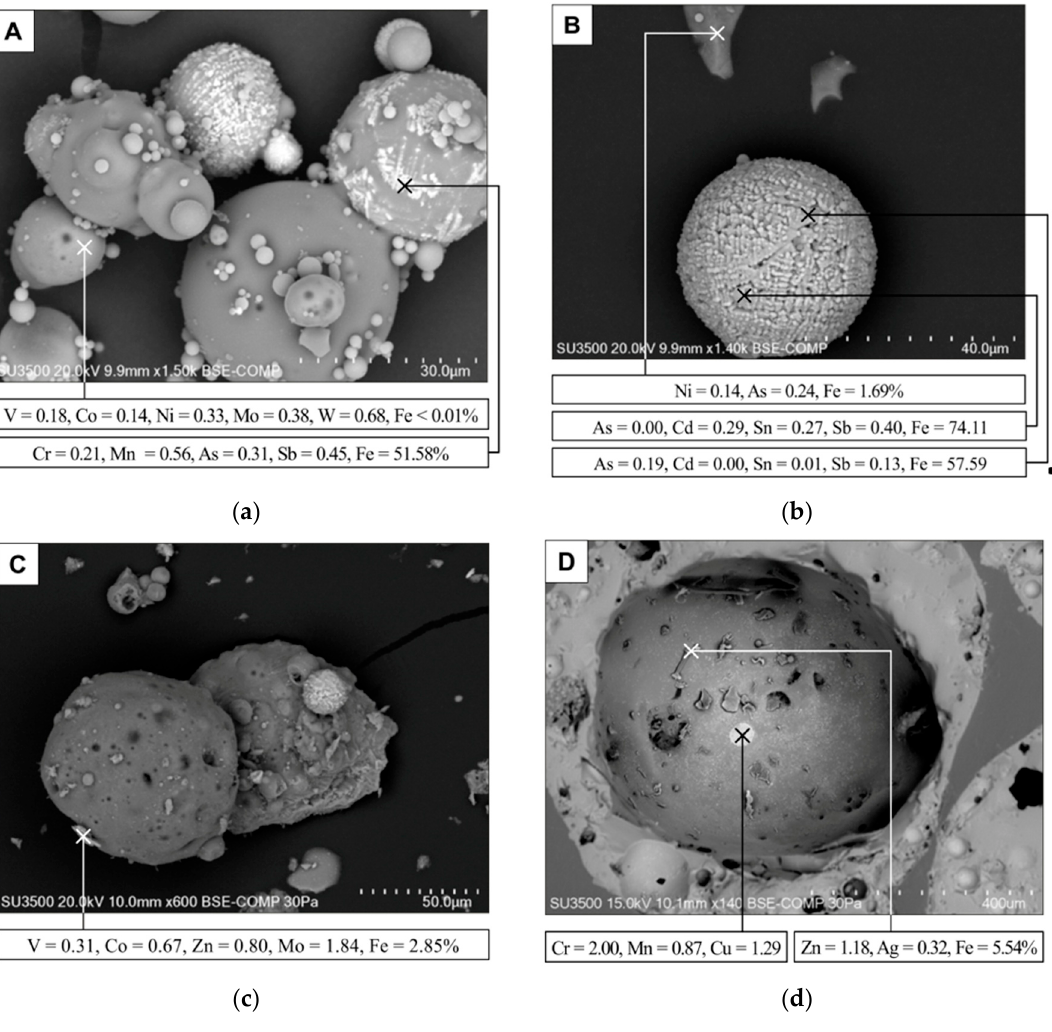
Figure 2. Sample results of the SEM/EDS analysis of elements content (% wt) in ( a ) Al-Si microspheres with magnetite skeletals and dendrites in fly ash (sample K9, feed coal from the LCB); ( b ) Al-Si grain and Al-Si microsphere with magnetite skeletal in fly ash (sample K9, feed coal from the LCB); ( c ) isolated magnetite crystal on Al-Si grains from slag (sample J5, feed coal from the USCB); and ( d ) Al-Si cenosphere in fly ash (sample M6, feed coal from the USCB).